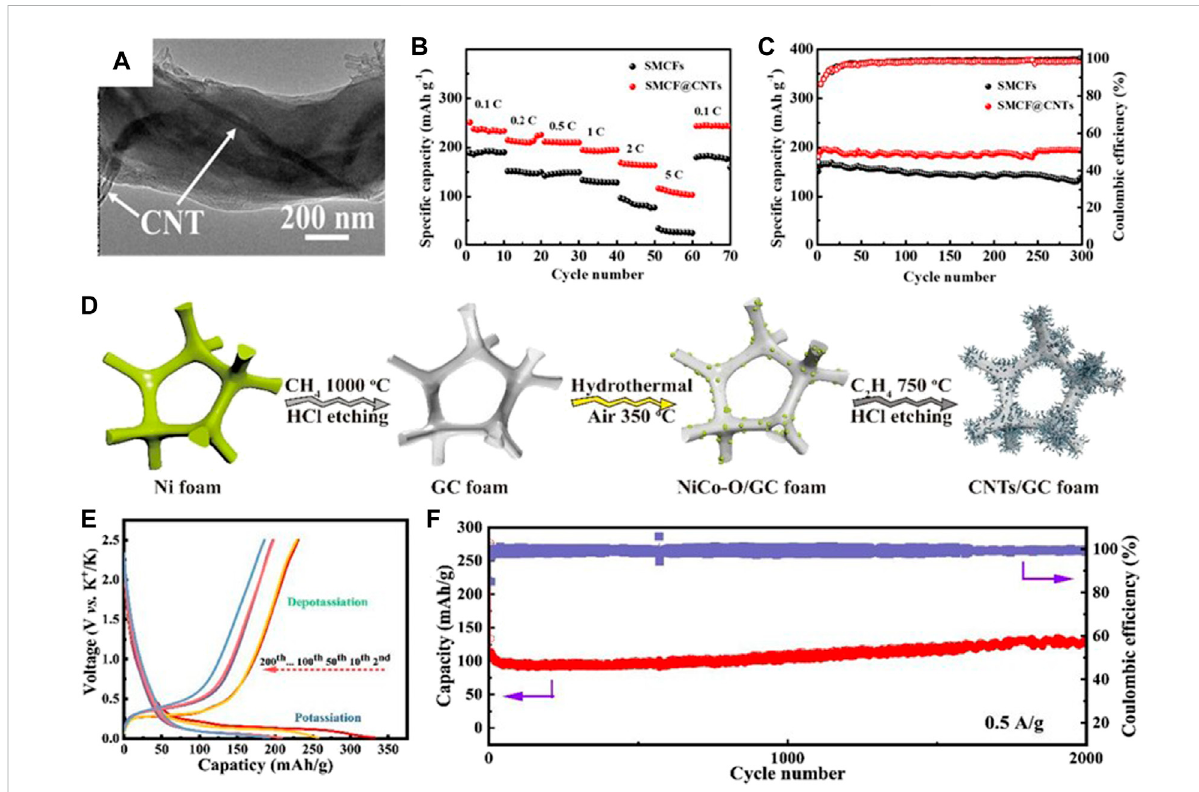
FIGURE 10 (A) TEMimageof SMCF@CNTs. (B) Rate performancefrom 0.1to 5 C. (C) Cyclingperformance at1 C.Reproduced with permission(Shenet al., 2019). Copyright 2019 ACS. (D) Fabrication diagram of CNTs/GCF. (E) Voltage pro fi les at 0.1 A g − 1 and (F) long-term cycle performance at 0.5 A g − 1 for CNTs/GCF. Reproduced with permission (Zeng et al., 2019). Copyright 2019